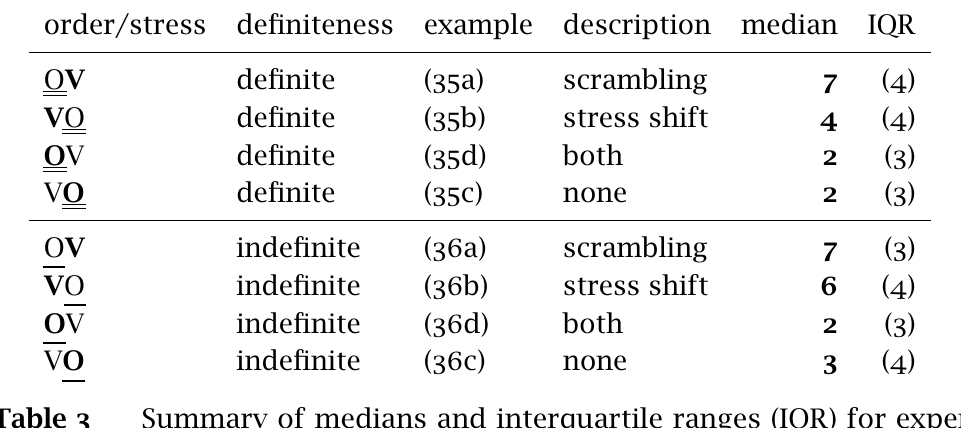
Summary of medians and interquartile ranges (IQR) for experi- ment